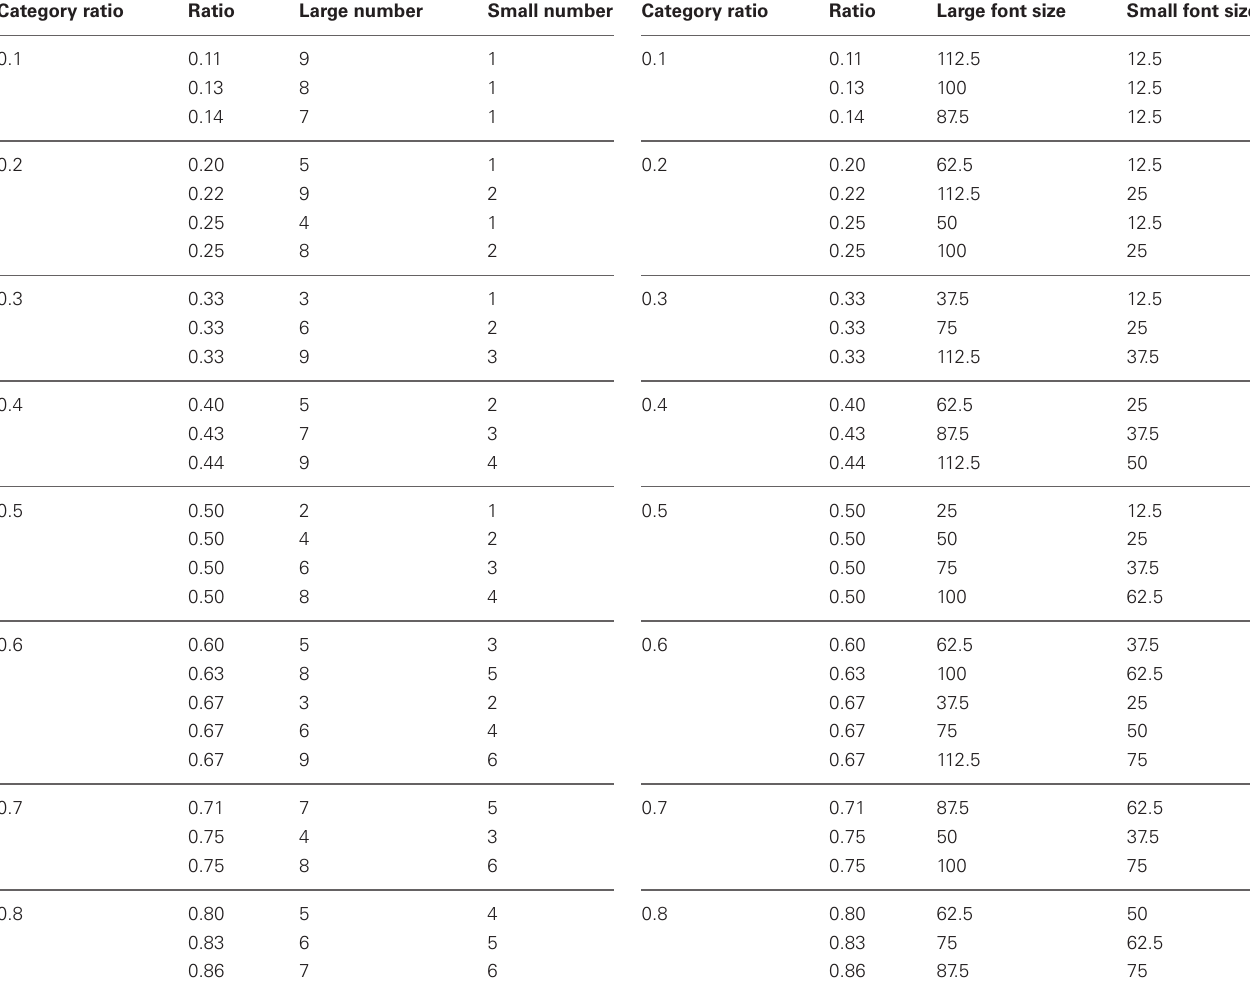
Table 1 | Pairs of stimuli by numerical ratio. Table 2 | Pairs of stimuli by physical